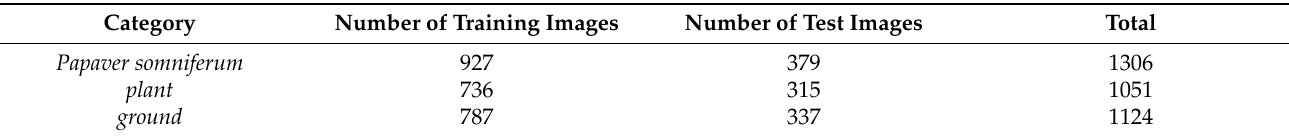
Figure 2. Classification dataset. Table 3. The specific number of data items in the dataset.